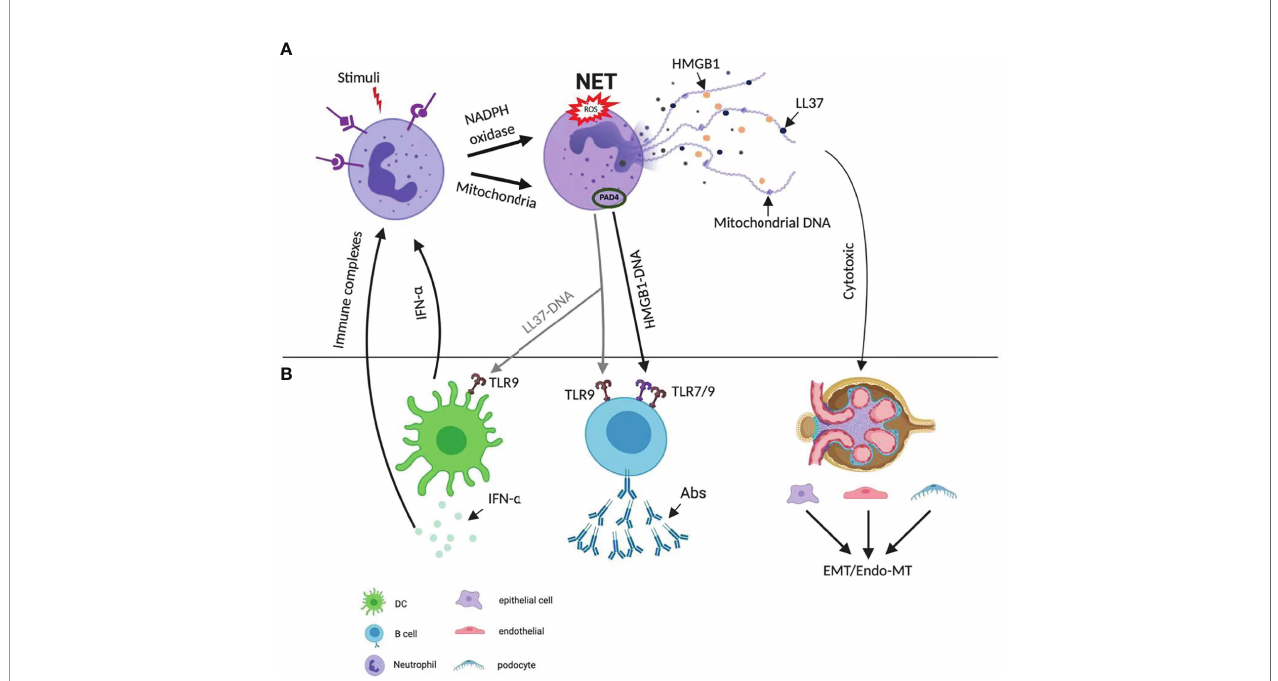
FIGURE 4 | Diverse mechanisms of NETs ’ role in pathogenesis of lupus. (A) NET formation starts with the activation of neutrophils through triggering of stimuli, which activate NADPH and mitochondria pathway. The latter promotes the citrullination of histone and facilitates their interaction with DNA. NETs are enriched in oxidized mitochondrial DNA, LL37 and HMGB1. (B) The extruded DNA from NETs is highly immunogenic. It activates plasmacytoid dendritic cells via TLR9 signaling, leading to the production of IFN- a . LL37-DNA complexes and DNA – HMGB1 complexes directly trigger polyclonal B cell activation via TLR9 or TLR7/9 and produce autoAbs. Both IFN- a and immune complex activate neutrophils, lead to more NETs formation and a positive feedback cycle. NETs can also have a direct cytotoxic effect on renal epithelial and endothelial cells via the externalization of histones, and therefore lead to epithelial-mesenchymal transition (EMT), endothelial- mesenchymal transition (Endo-MT). Abs, antibodies; EMT, epithelial-mesenchymal transition; Endo-MT, endothelial-mesenchymal transition; HMGB1, high-mobility group box 1; IFN, interferon; NADPH, nicotinamide adenine dinucleotide phosphate hydrogen; NET, neutrophil extracellular trap; PAD, peptidyl arginase deaminase; ROS, reactive oxygen species; TLR, toll-like